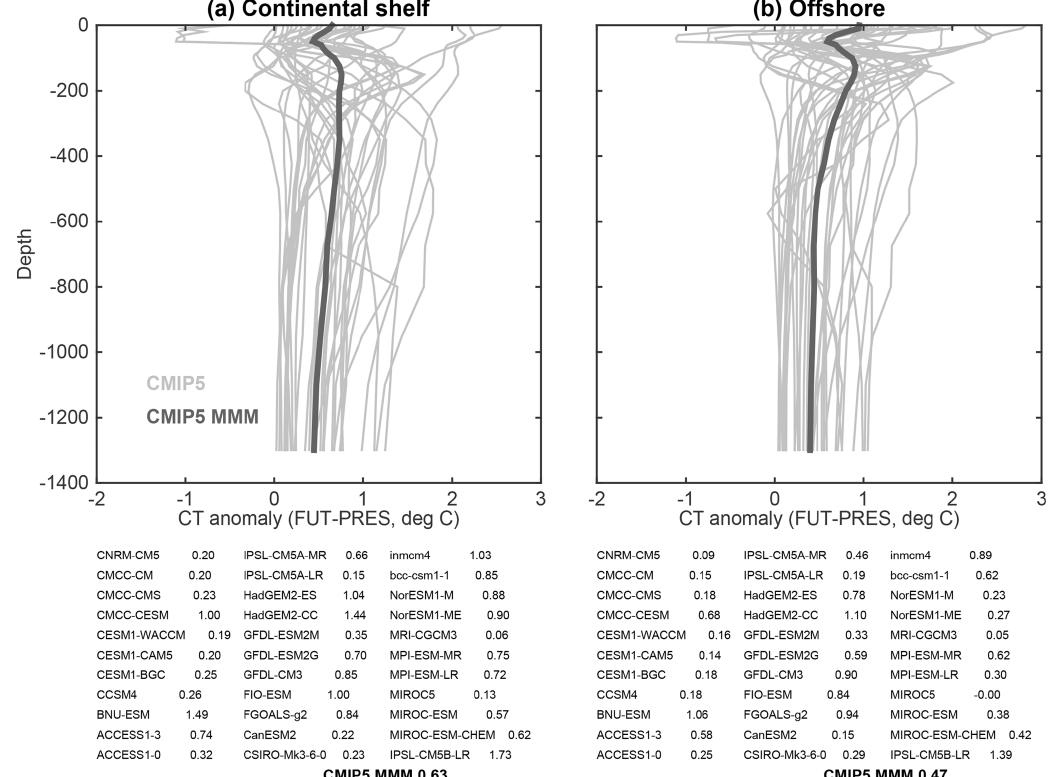
Figure E1. Temperature anomaly (2080–2100 mean minus 1989–2009 mean) in the Amundsen Sea (76–69 ◦ S, 128–90 ◦ W) from 33 CMIP5 models in the RCP85 scenario. Continental shelf temperatures (a) are averaged over the area where the sea floor is shallower than 1500m, while offshore temperatures (b) are averaged over the rest of the domain. The numbers for individual CMIP5 models and the multi-model mean (MMM) indicate the mean ocean warming in the 500–800m